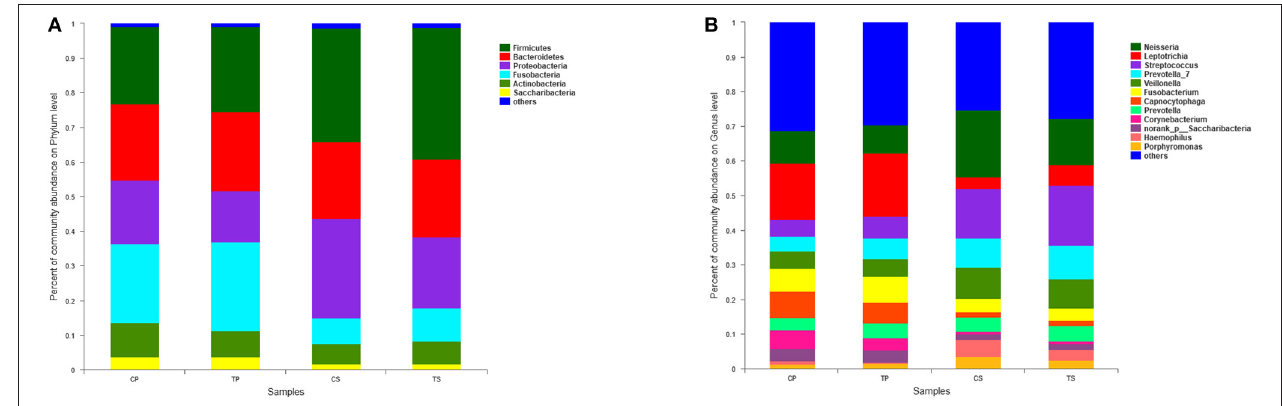
FIGURE 2 | The distributions of the predominant bacteria. (A) Results at the phylum level. (B) Results at the genus level. The predominant taxa (relative abundance > 2% on average) are shown.